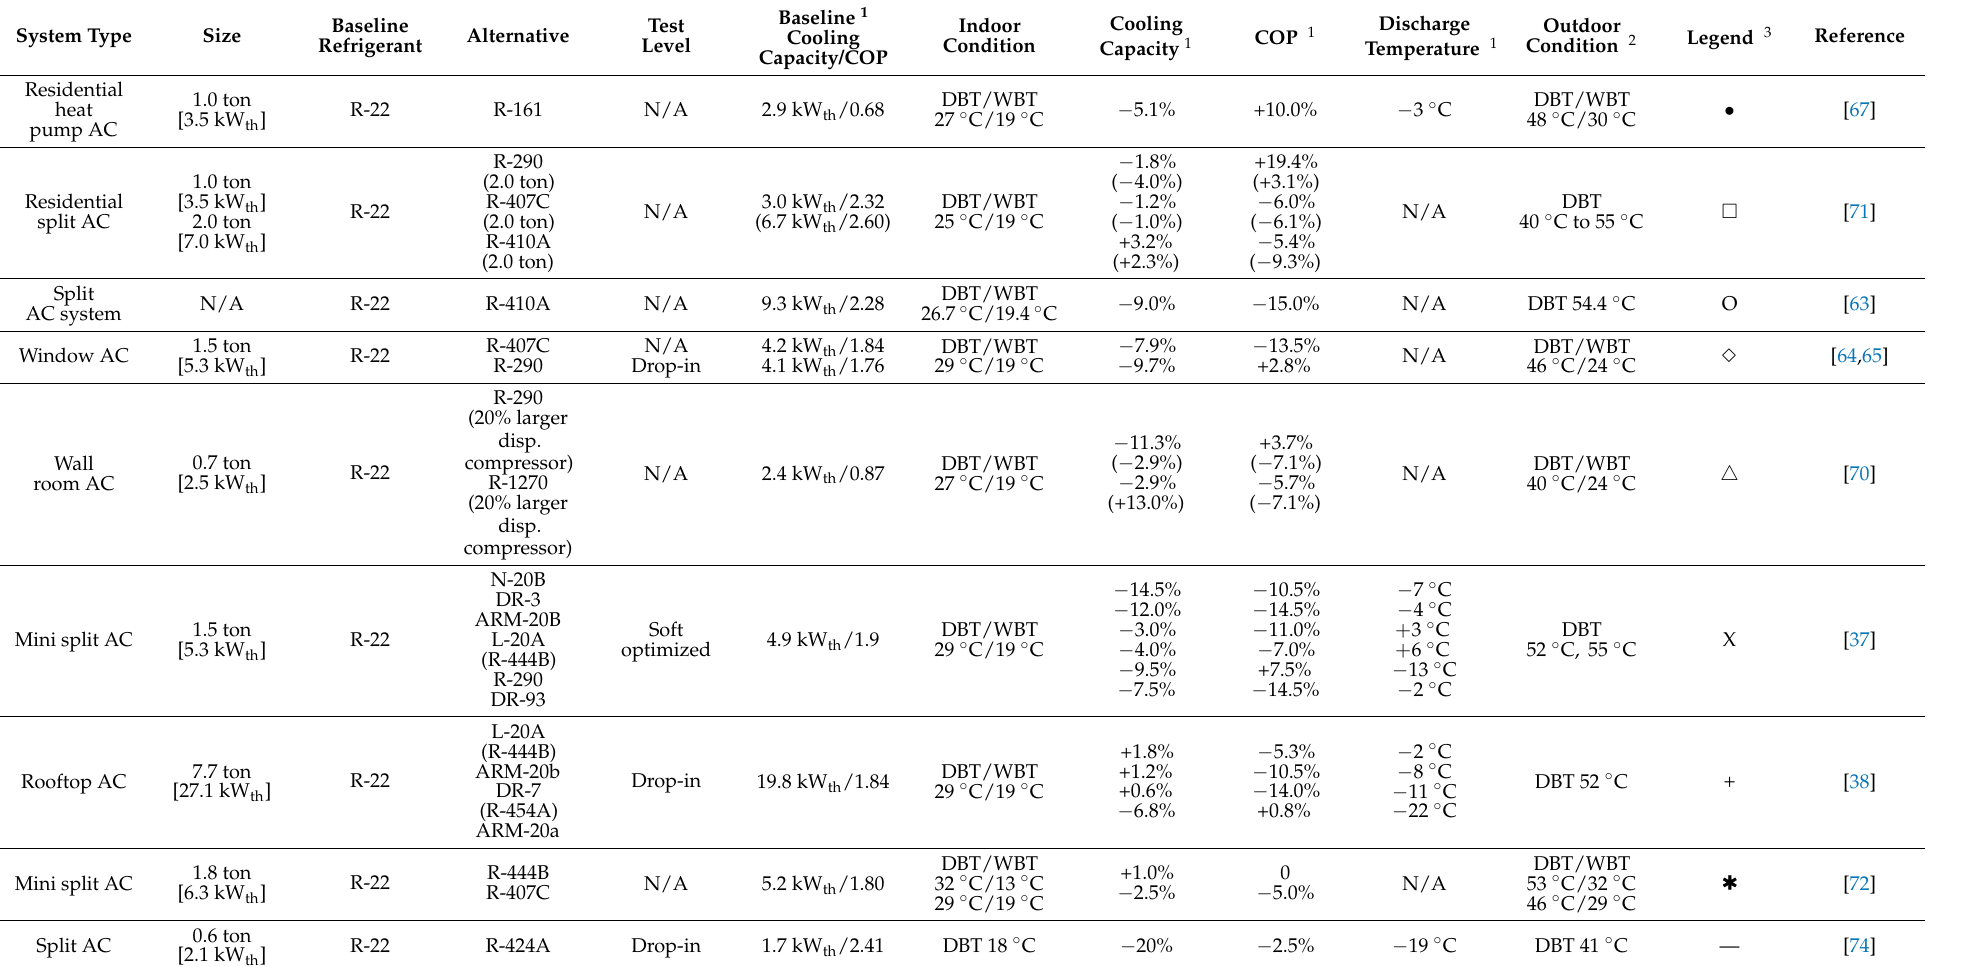
Table 9. Experimental results for R-22 alternative refrigerants at HAT conditions.